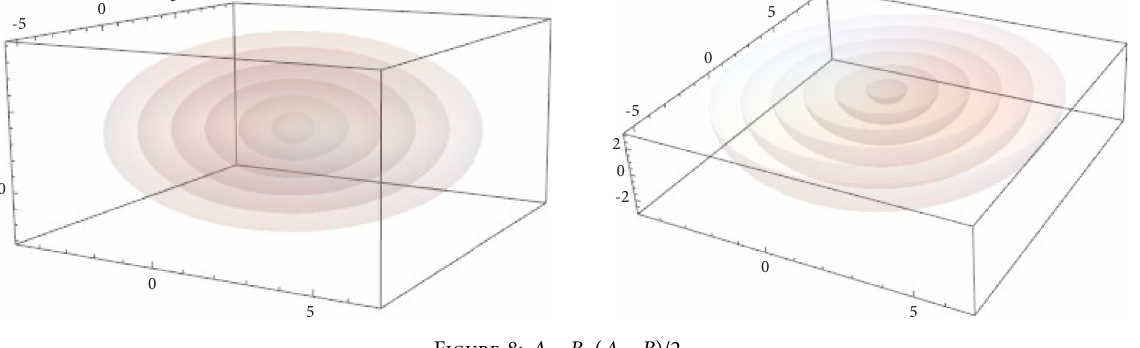
Figure 8: A − B, ( A − B ) /2.